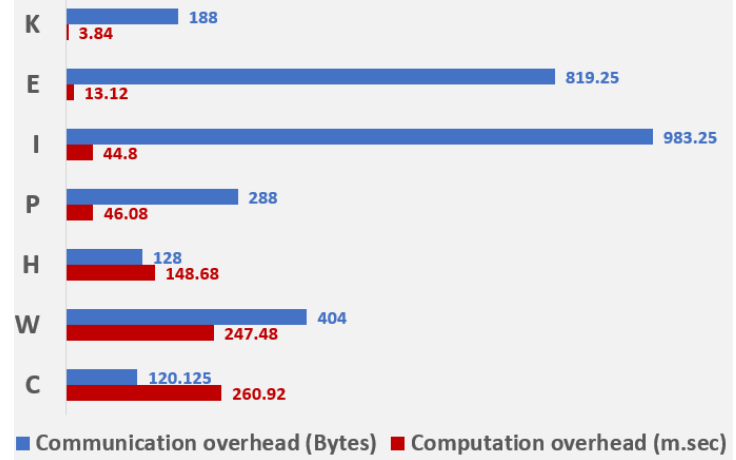
Figure 17. Computational and communication overheads of the authentication protocols.